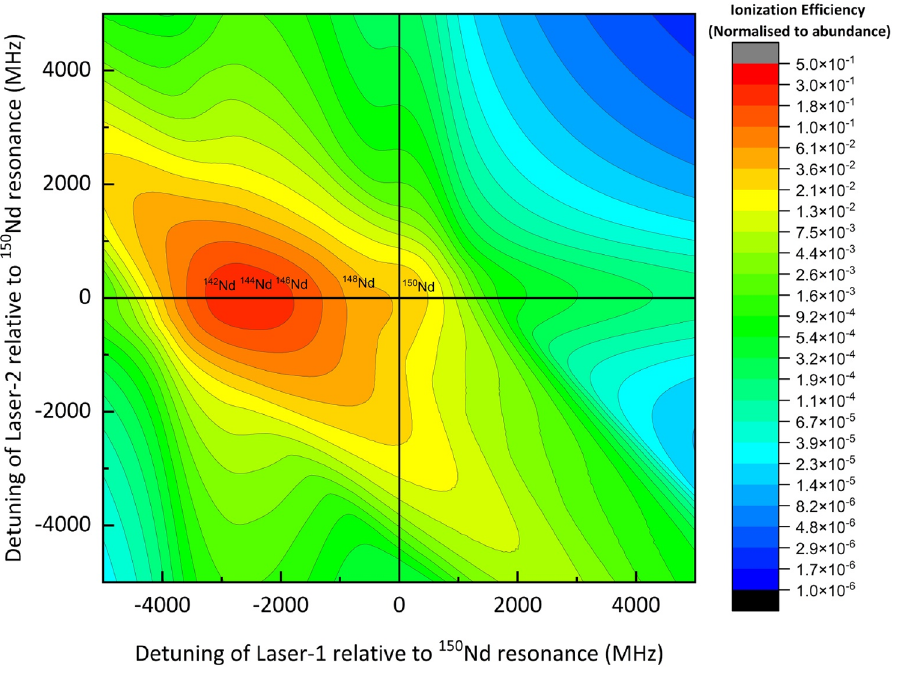
Figure 3. Two-dimensional contour plot of the ionization efficiencies of Nd isotopes (frequencies relative to the resonance frequency of 150 Nd isotope). Bandwidth of the excitation lasers is set to 100 MHz, angular divergence of the atomic beam is 60° and the peak power densities of the excitation lasers are set to 20, 20 and 78,000 W/ cm 2